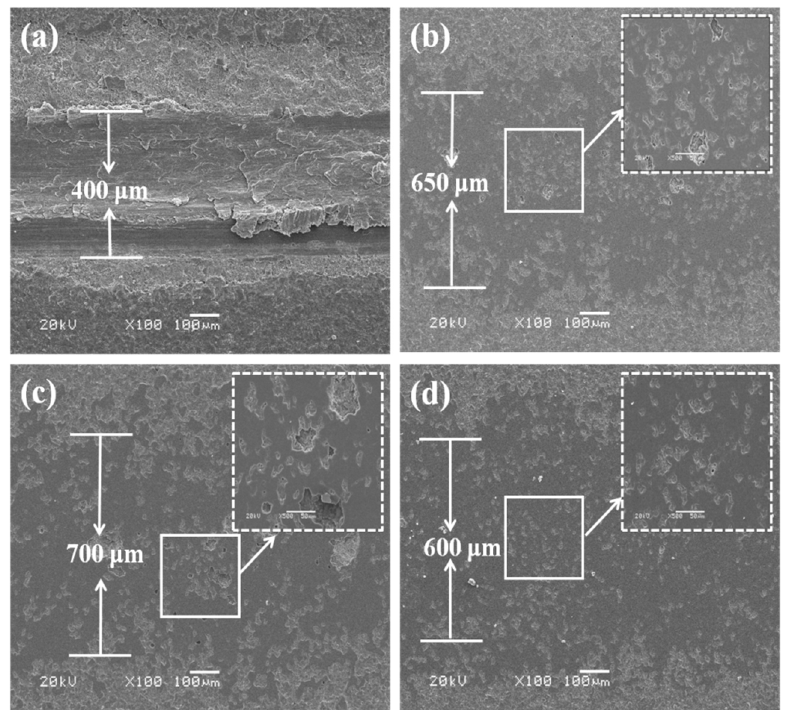
Figure 7. Friction coefficient as a function of sliding time under 5 N for P30, Al30, P60, and Al60 coating.